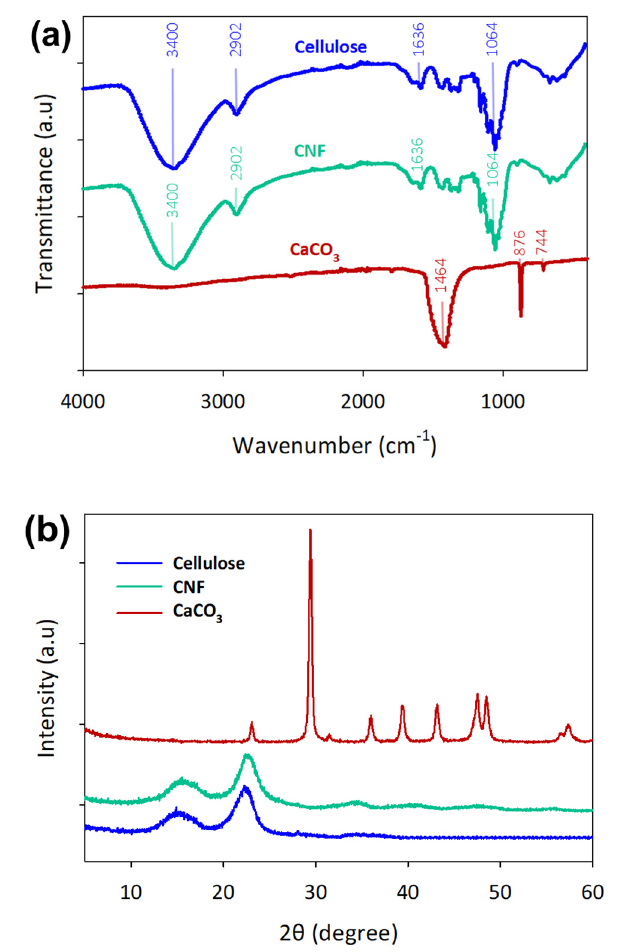
Figure 2. Characterization of isolated cellulose, cellulose nanofibrils (CNF) and CaCO 3 on ( a ) Fourier transform infrared (FTIR) spectroscopy and ( b ) the X-ray diffractometry (XRD) spectrum.